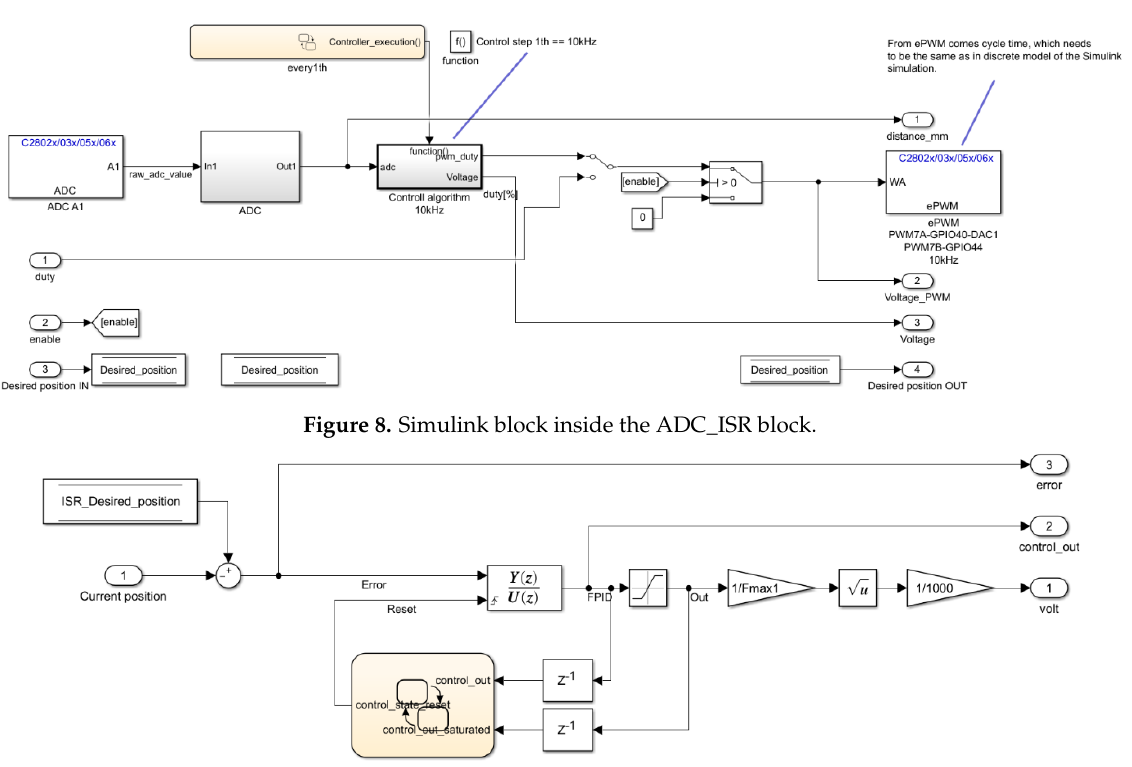
Figure 9. Simulink model of the fractional control algorithm with the quasi-anti-windup method.